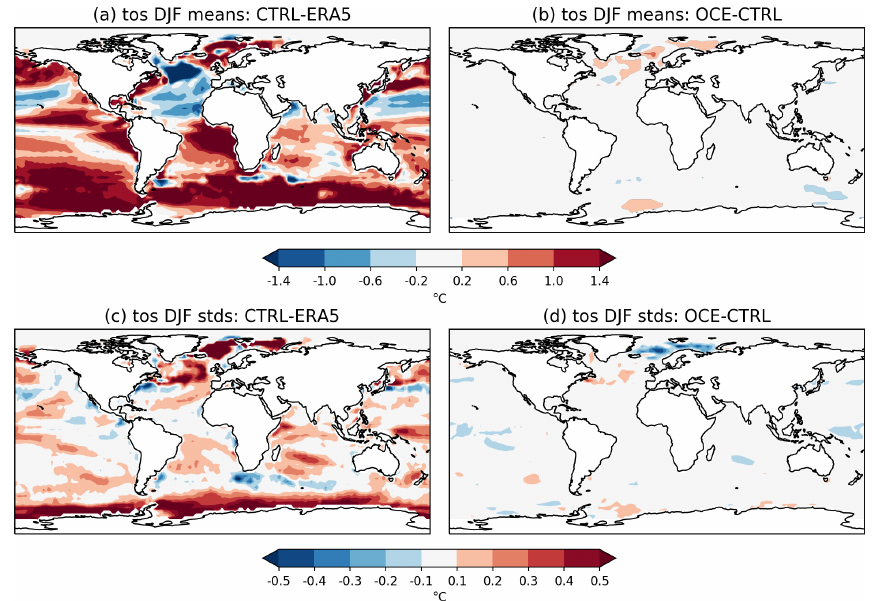
Figure 2. Sea surface temperature (mean and standard deviations) in DJF. Mean quantities in (a) CTRL − ERA5 and (b) OCE − CTRL. Standard deviations in (c) CTRL − ERA5 and (d) OCE − CTRL. In each plot, every grid point outside the zero contour is significant ( p < 0 . 05). The period considered is 1980–2015.